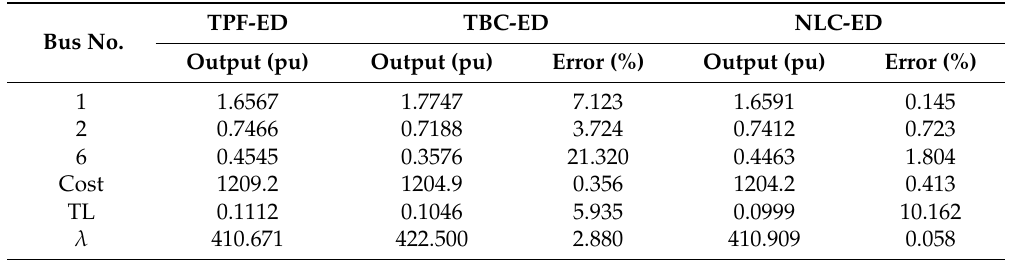
Table 7. ED simulation results compared with traditional ED and new loss coefficients of the IEEE 14-bus system under the nonconforming system demand change condition.